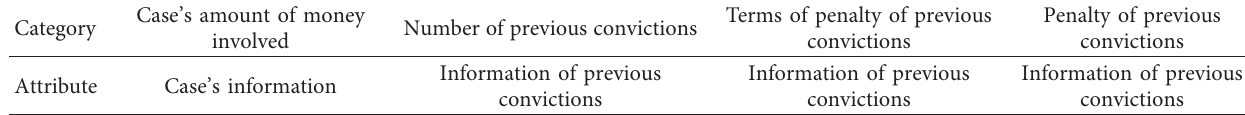
Table 2: Continuous data.